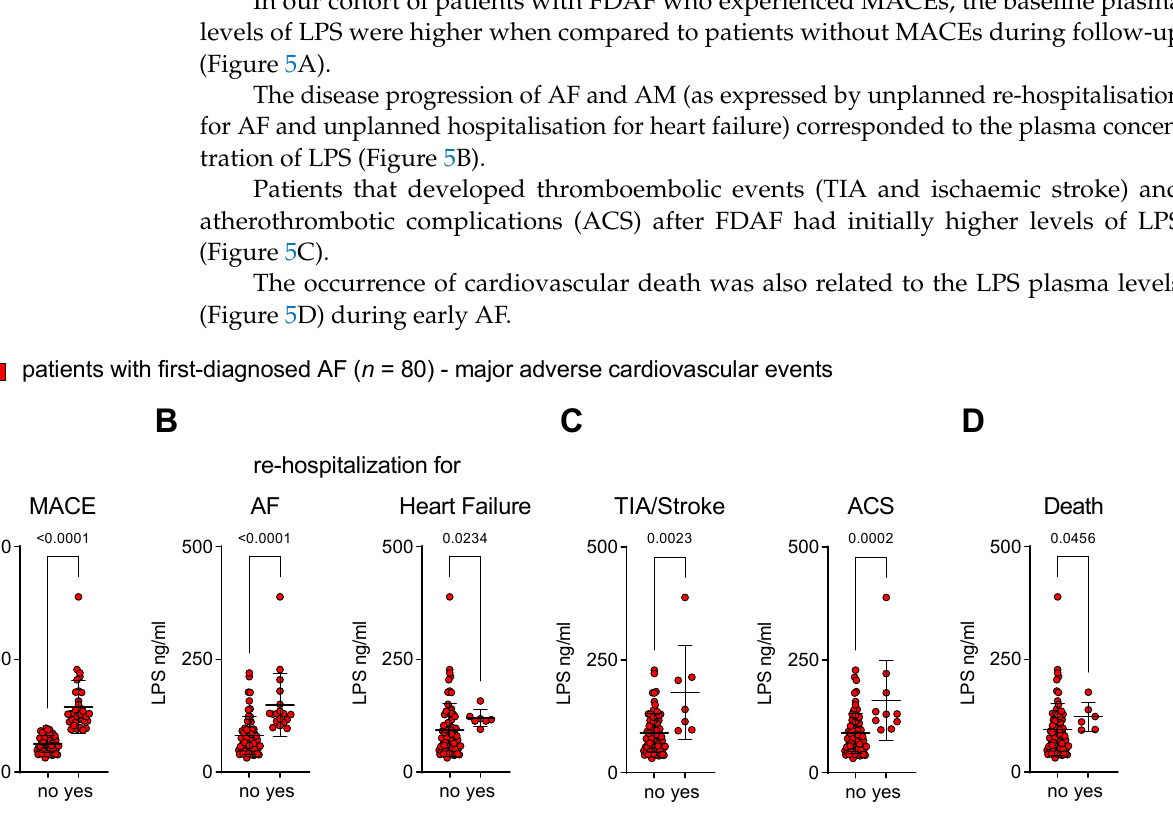
Figure 5. Circulating endotoxin associates with the onset of major adverse cardiovascular events after first diagnosis of AF. Patients were stratified into two groups according to the occurrence of MACE (no vs. yes) during follow-up after their first diagnosis of AF. ( A ) Composite endpoint MACE: first occurrence of cardiovascular death, unplanned re-hospitalisation for AF, unplanned hospitalisation for heart failure (HF), transient ischaemic attack (TIA), ischaemic stroke, acute coronary syndrome (ACS), deep vein thrombosis, peripheral thromboembolism. Adverse outcome events that are associated with disease progression of AF (unplanned re-hospitalisation for AF, unplanned hospitalisation for HF) ( B ), thromboembolic and atherothrombotic complications (TIA, ischaemic stroke, ACS) ( C ) and cardiovascular death ( D ) are related to circulating LPS at time of first diagnosis of AF. Results are expressed as single values ( n = 80), mean ± SD, and p -values.